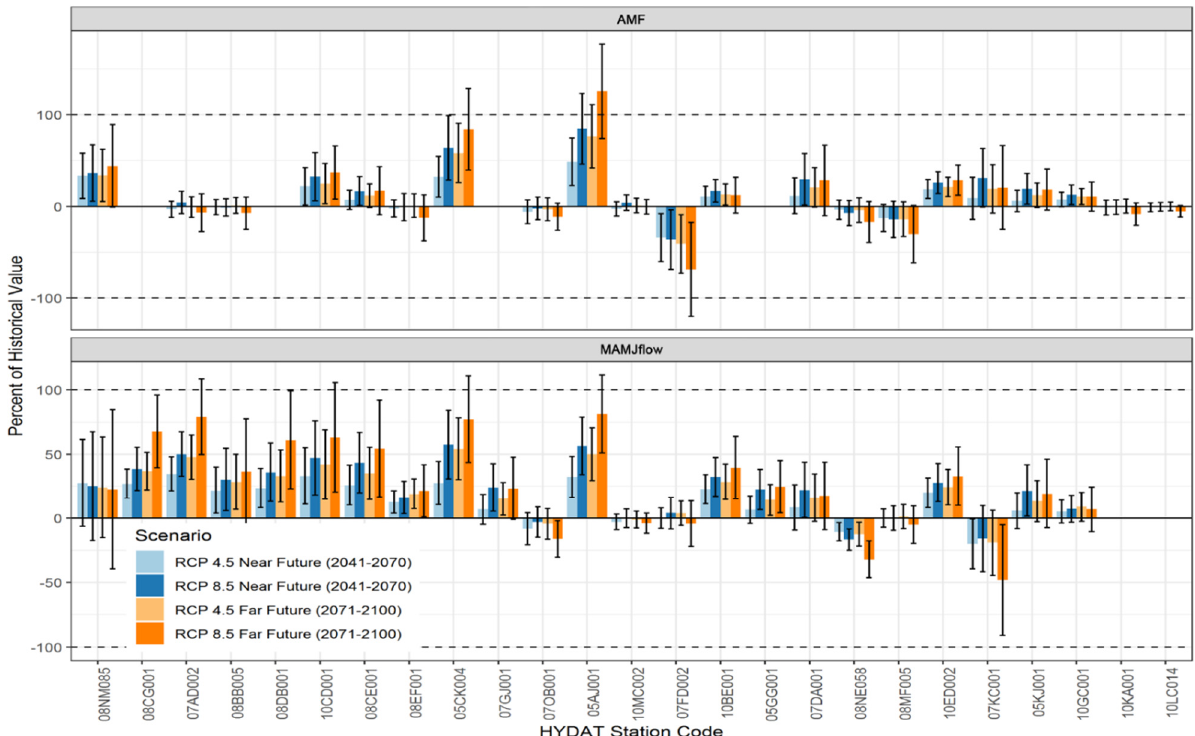
Figure 7. Mean projected changes in annual maximum flow (AMF) and mean spring flow (MAMJflow) for the two RCPs and two future periods computed with the MLR models at each of the hydrometric stations (predictions made with SWEmax; error bars indicate the 95% confidence interval in future values).